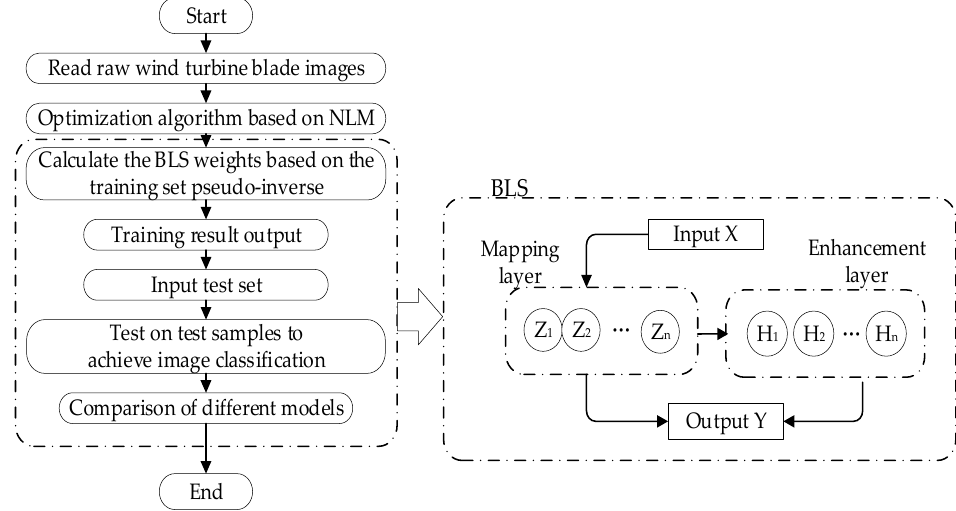
Figure 5. Flowchart of damage detection in wind turbine blades based on the CBNLM ‐